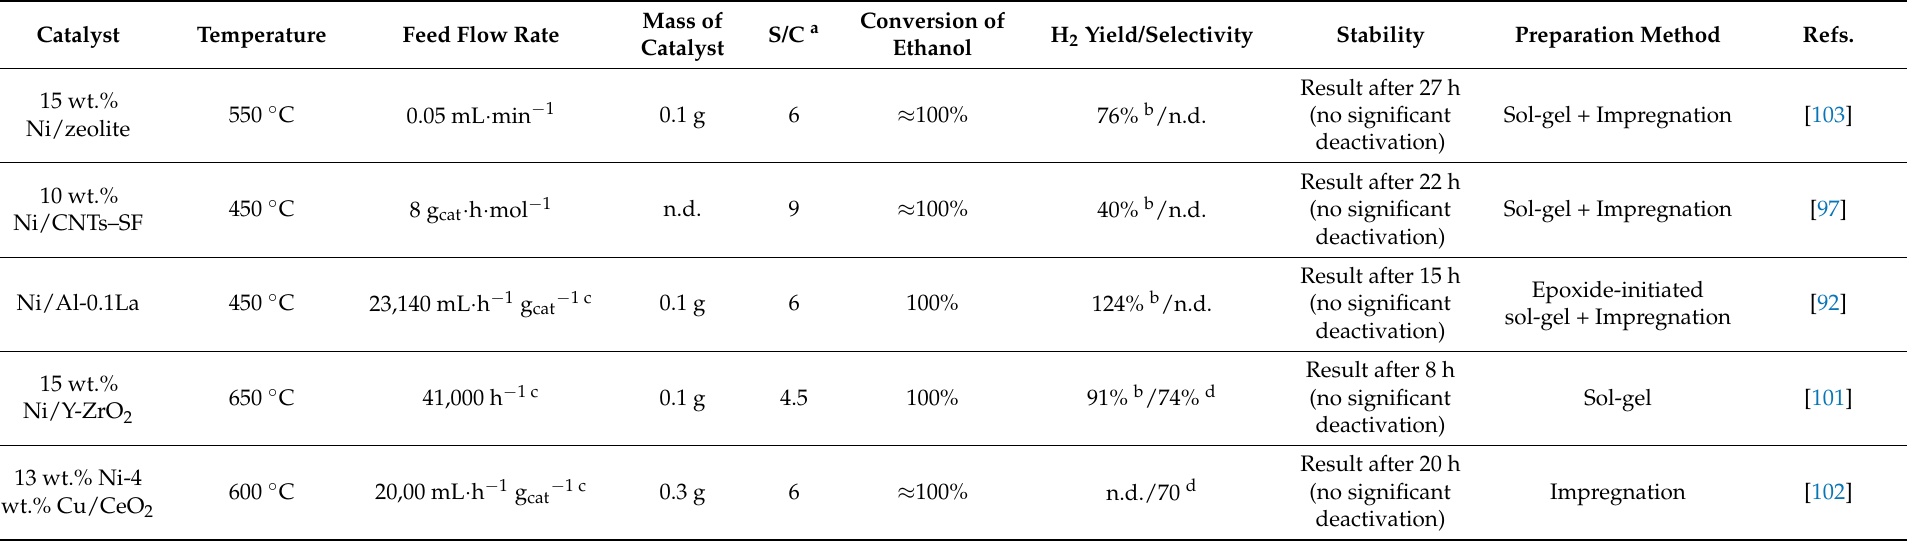
Table 4. Comparison of some of the most promising ESR catalysts reviewed in this